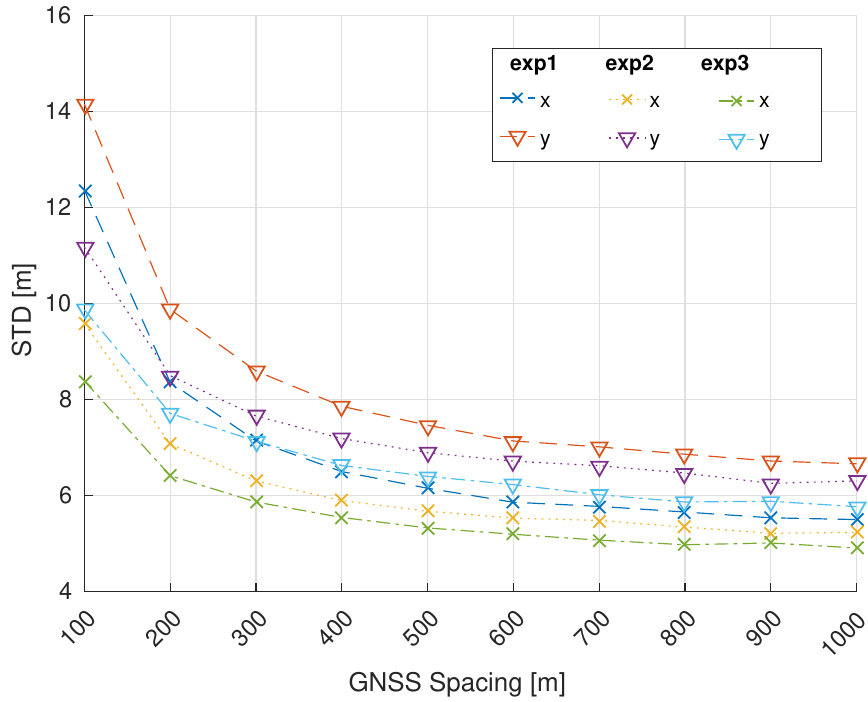
Figure 4. Ice-relative vehicle x − y position uncertainty averaged over the 7.7 km simulated mission, plotted as a function of GNSS spacing for exp1, exp2, and exp3. Increasing the number and separation of GNSS units is positively correlated with decreased ice-relative position